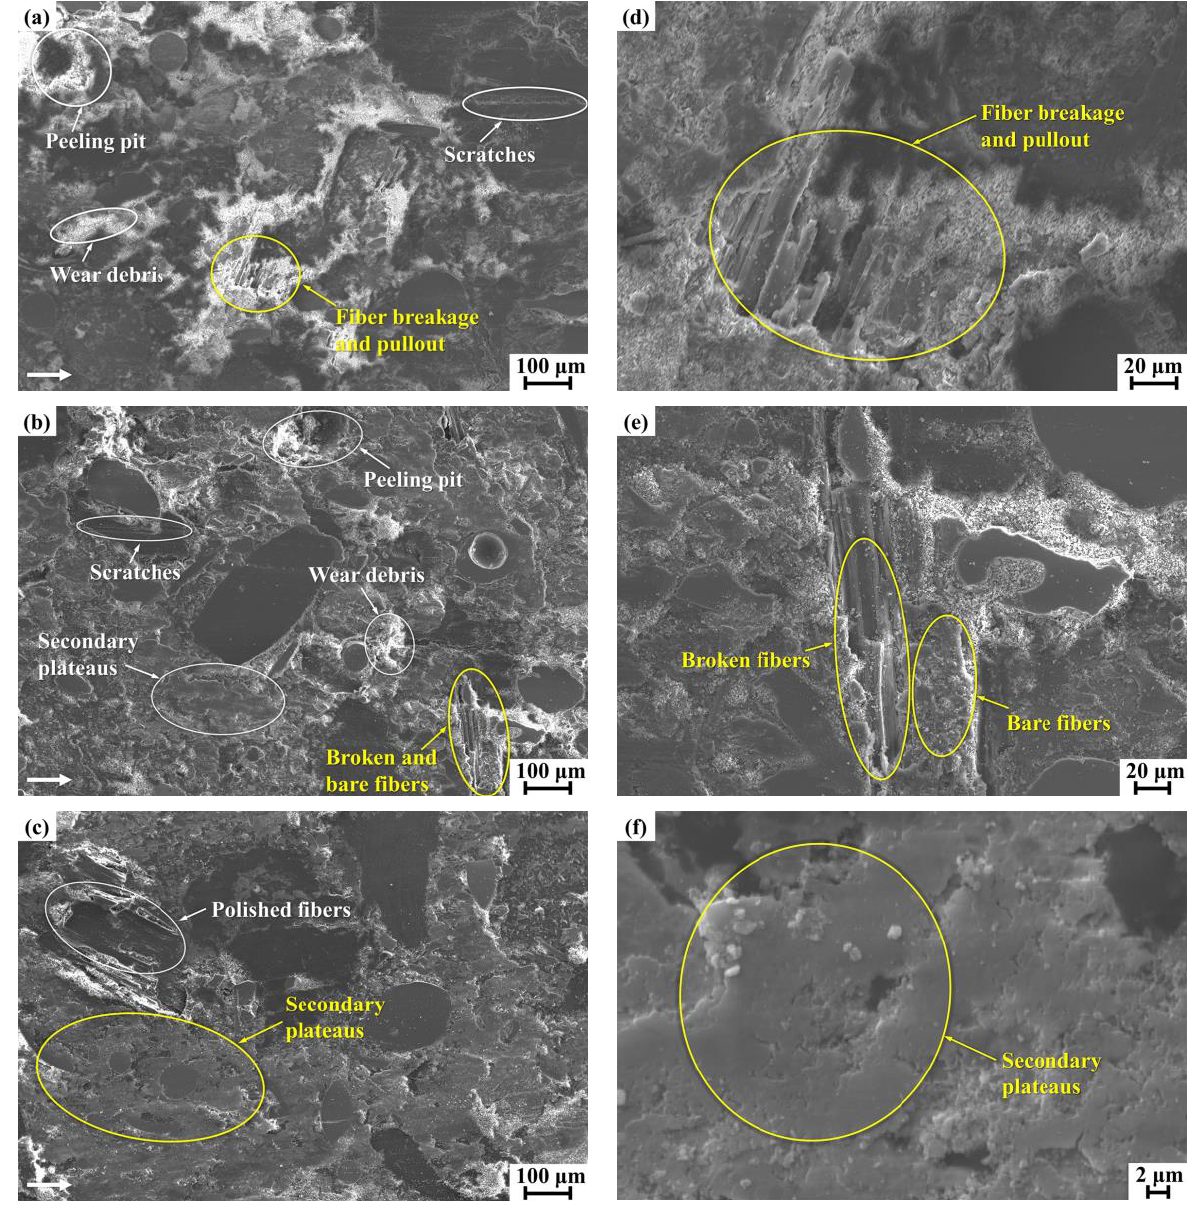
Figure 7. The worn surface morphologies of the tested composite materials: ( a , d ) FMSF; ( b , e ) FMUF; ( c , f ) FMHF. For the composite FMUF (Figure 7b), the worn surface showed evidence of a reduced number of wear pieces and particles, wear scratches, and peeling pits, together with a few